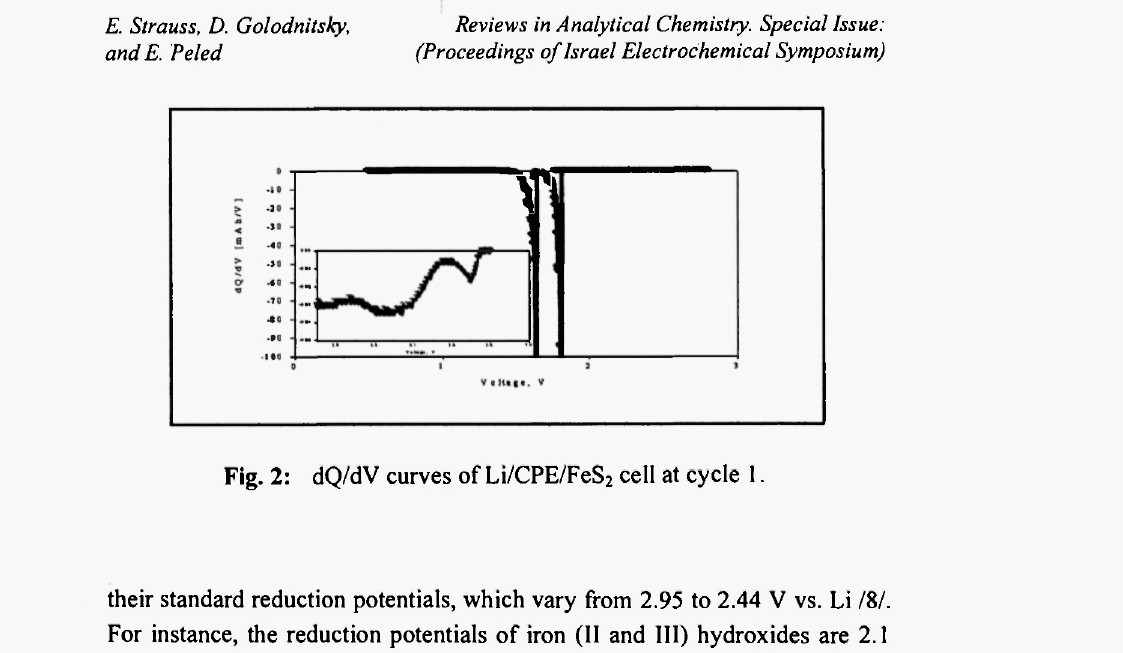
their standard reduction potentials, which vary from 2.95 to 2.44 V vs. Li /8/. For instance, the reduction potentials of iron (II and III) hydroxides are